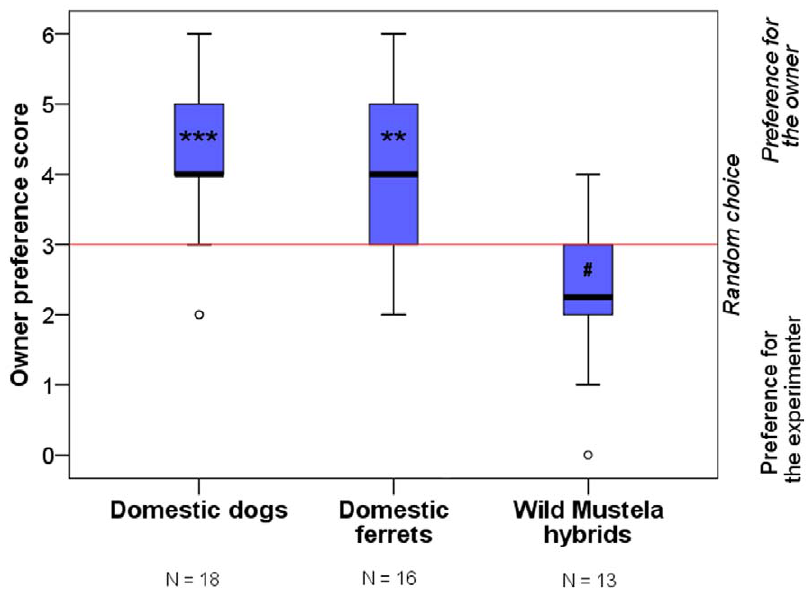
Figure 2. Number of trials with owner versus experimenter preferred out of six in total. Subjects had to choose between their owners and an unfamiliar experimenter while both of them were parallelly holding a piece of food and calling the subject. Red line represents the chance level. (***: p , 0.001, **: p , 0.01, # : p , 0.1; median, quartiles, whiskers and outliers).